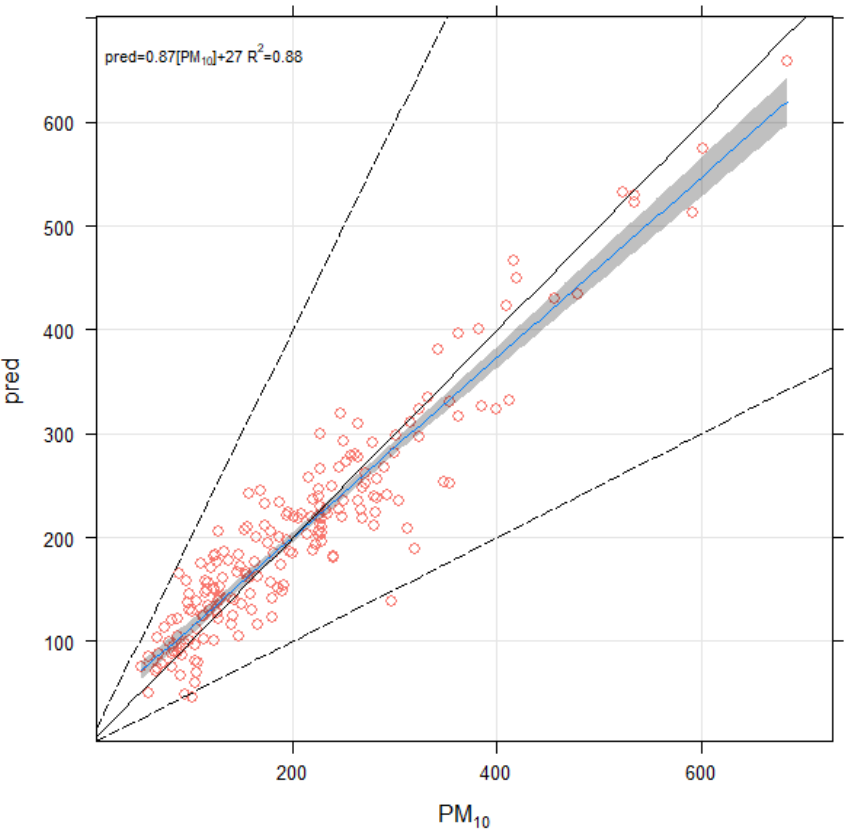
Figure 5. Scatter plot between measured and GAM predicted PM 10 concentrations ( µ g/m 3 ). The 1:1 line is solid black and the 1:0.5 and 1:2 lines are dashed black. Together these lines help show how close a group of points are to a 1:1 relationship and show the points that are within a factor of two (FAC2). The solid blue line shows the linear model line with 95% confidence intervals. The equation of the line and R-square value is shown in the top-left of the panel.